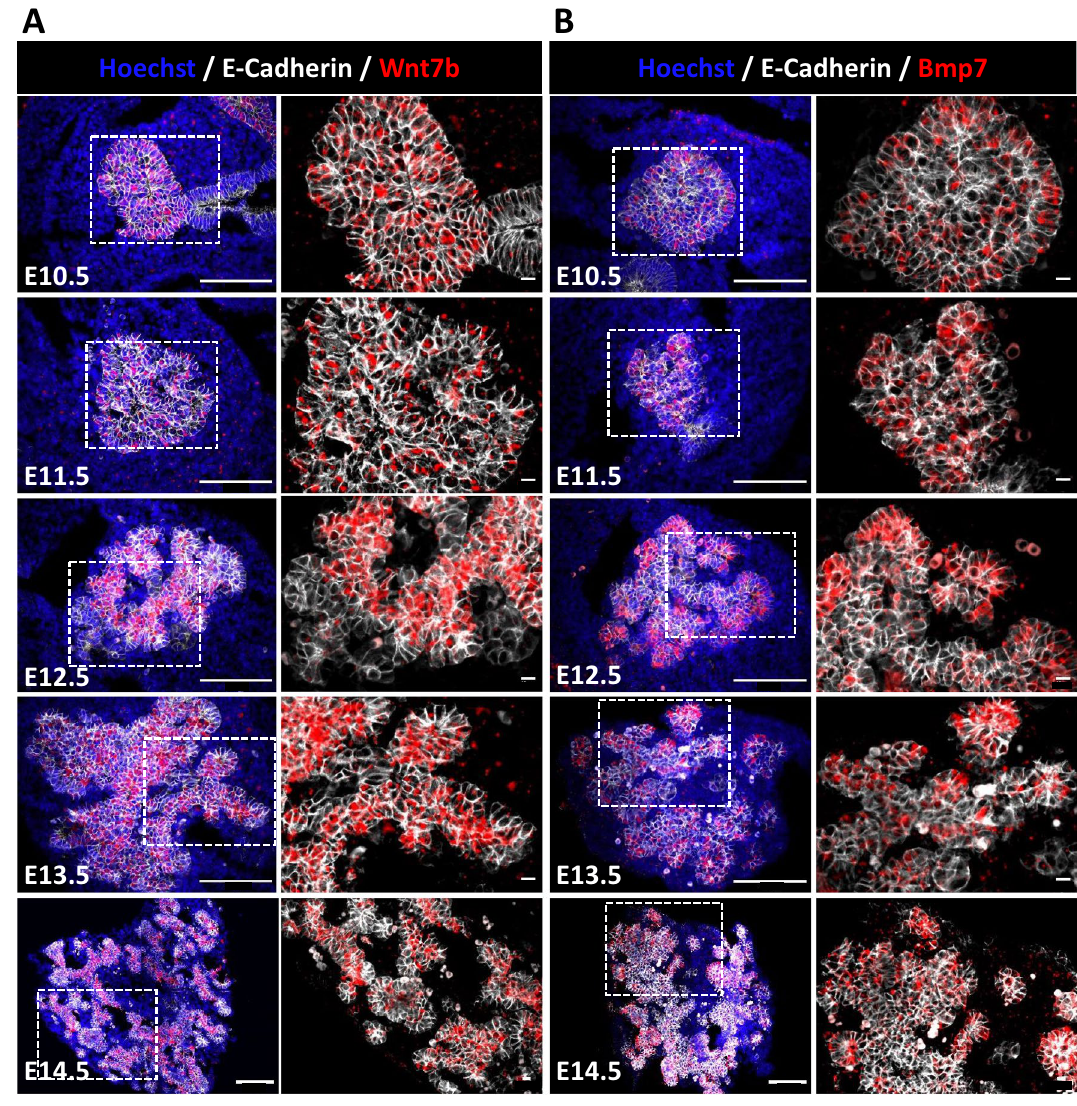
Figure 4. Localization of Wnt7b and Bmp7 expressing cells in developing pancreas. Detection of Wnt7b ( A ) and Bmp7 ( B ) transcripts by in situ hybridization (in red) on pancreatic tissue sections from E10.5 to E14.5, combined with an immunolabeling of E-Cadherin (white) to detect the epithelium. Nuclei were counterstained with Hoechst (blue). Regions delineated by dashed lines on the left images are magnified on the right, highlighting Wnt7b and Bmp7 mRNA expression in E-Cadherin positive trunk and tip cells, respectively. Scale bars: 100 μm (at left) and 10 μm (at